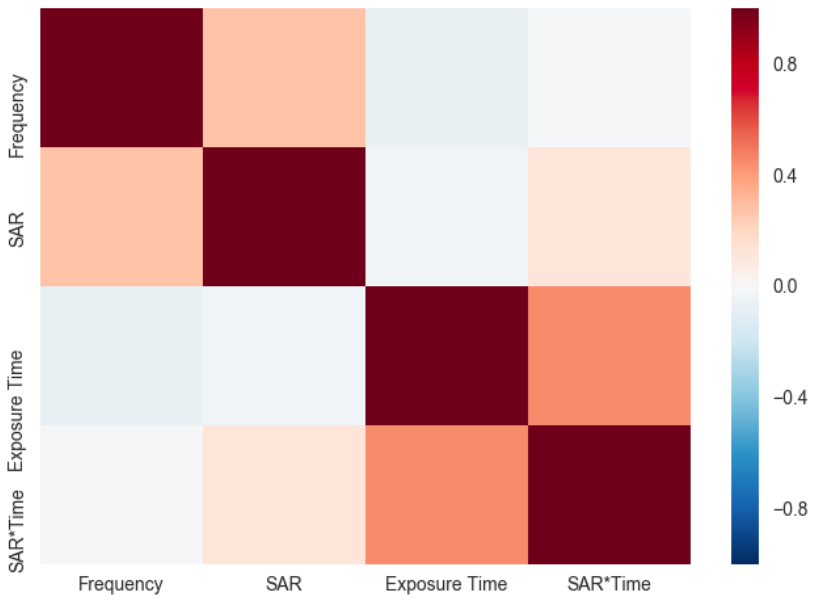
Figure 6. Correlations among attributes for RF-EMF on human and animal cells (maroon indicating strong correlation and blue signaling no correlation). Features that were selected for this analysis were frequency, SAR, exposure time, and SAR × exposure time (impact of accumulated SAR within the exposure